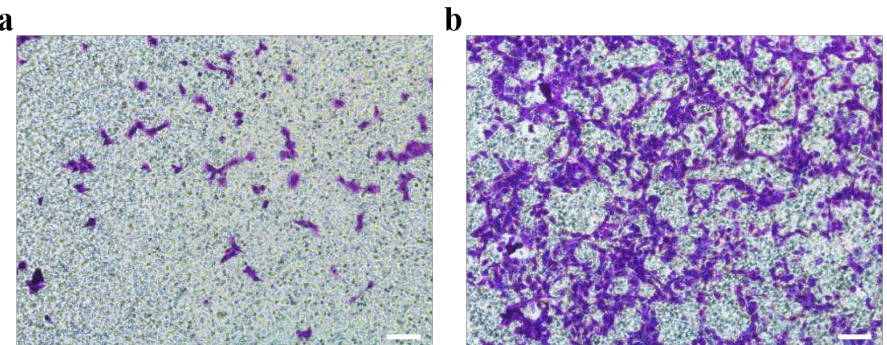
Figure 7. Comparison of metastasis ability between cells cultured in TCP ( a ) and gelatin@NWF ( b ). DU 145 cells were cultured in gelatin@NWF for 7 days. Then cells were collected and tested by Boden chamber assay, scale bar = 50 µm.